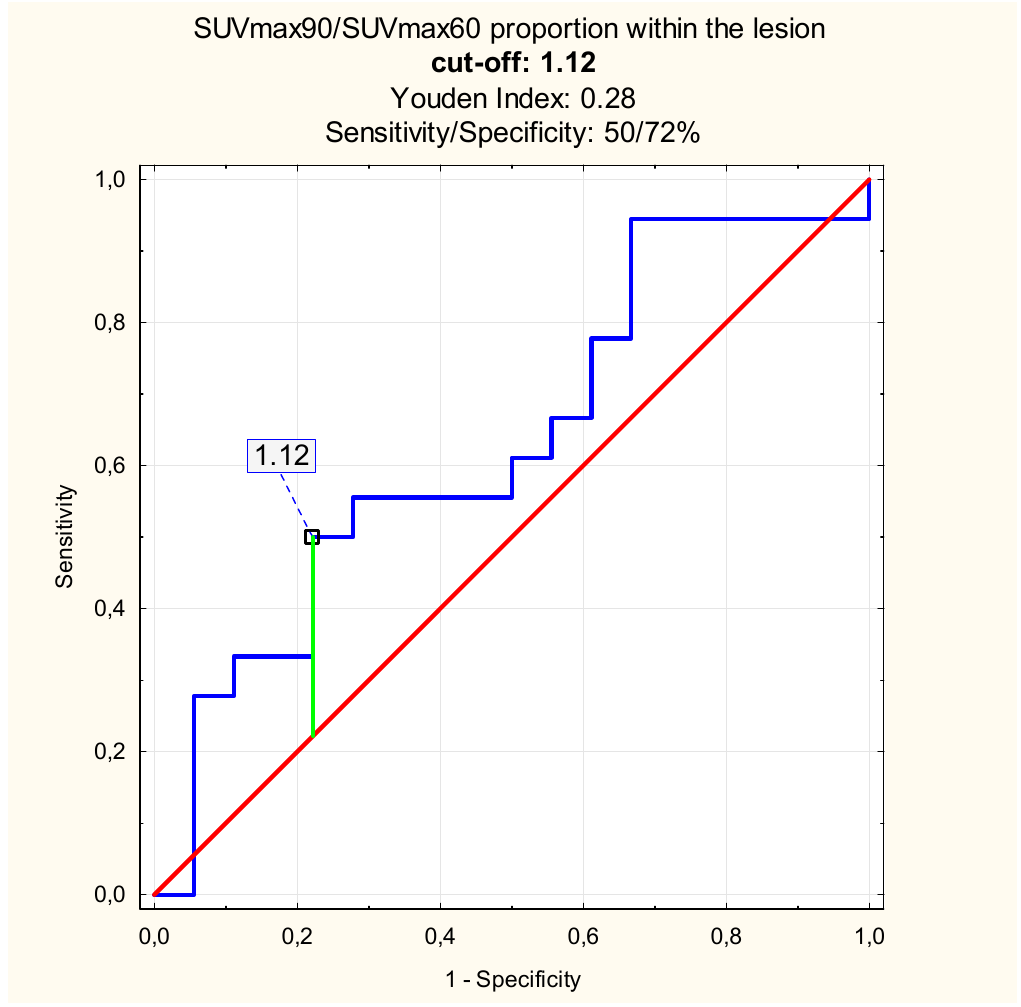
Figure 5. The proportion between the SUVmax value at 90, 60 min p.i. within the inflammation and malignant PT tumor: cut-off value (blue line—sensitivity, red line—specificity, green—cut-off point).